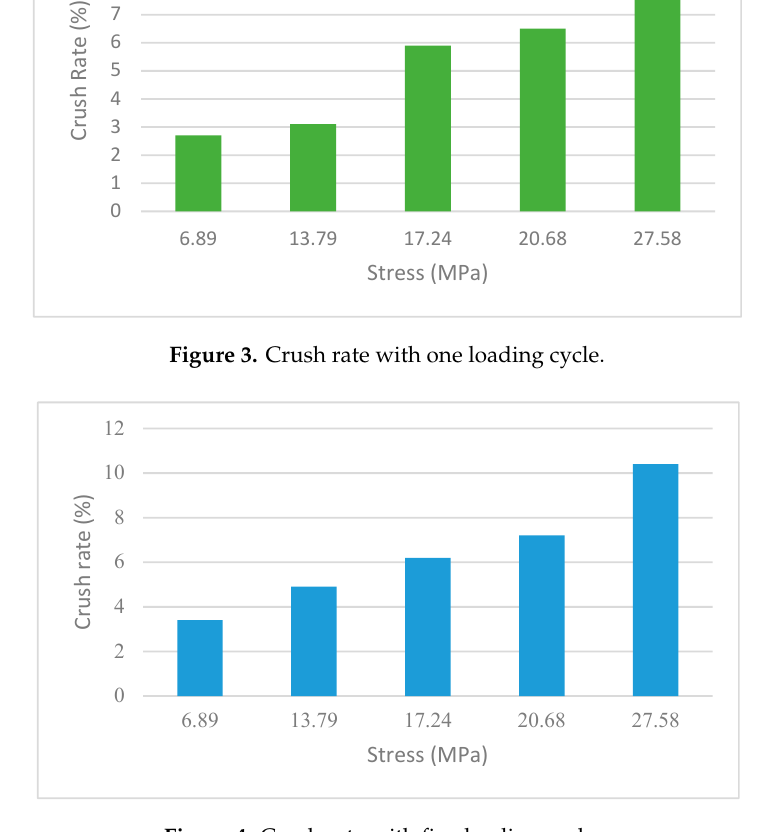
Figure 4. Crush rate with five loading cycles.